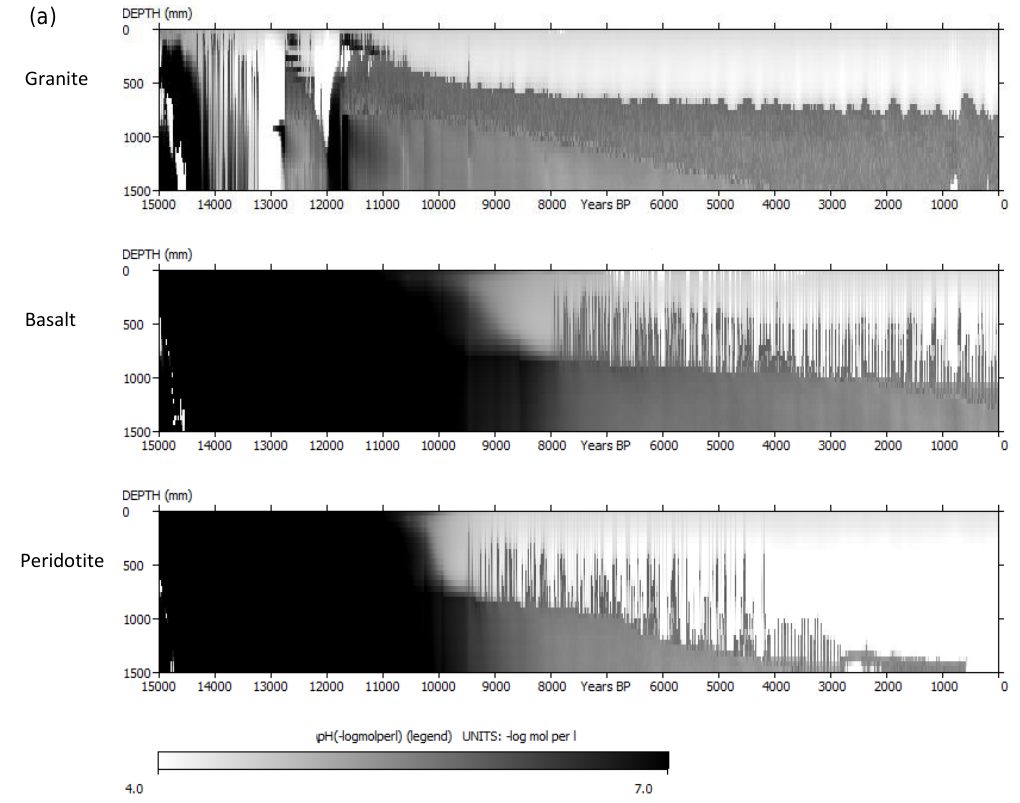
Figure 2. (a) Time-depth evolution of pH with physical weathering (Model A) for three parent materials with texture number 5 (Table